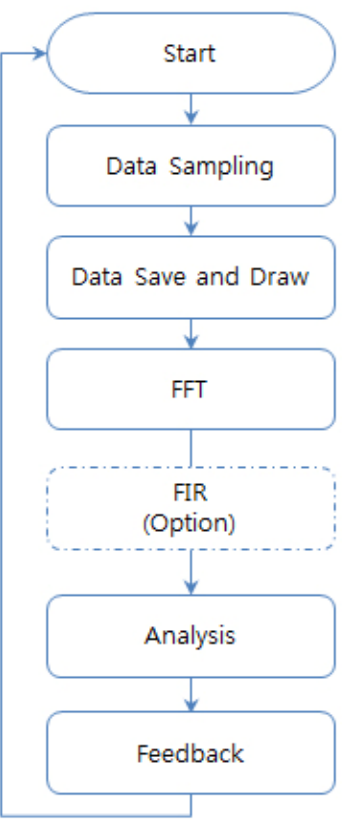
Figure 5. Flow chart of monitoring and analyzing